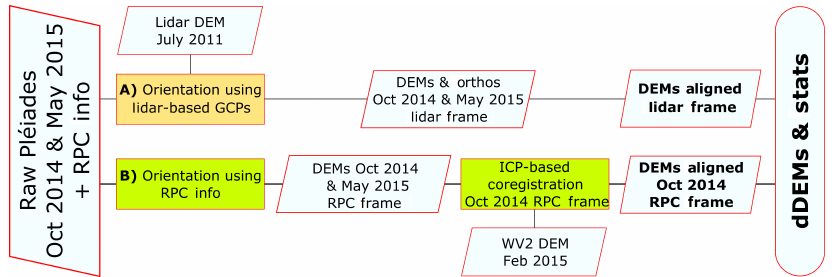
Figure 3. Flowchart of the different schemes studied for obtaining unbiased DEMs. Rectangles indicate processing steps and parallelograms indicate products. Orange squares indicate processing with ERDAS software, and green squares indicate processing with ASP